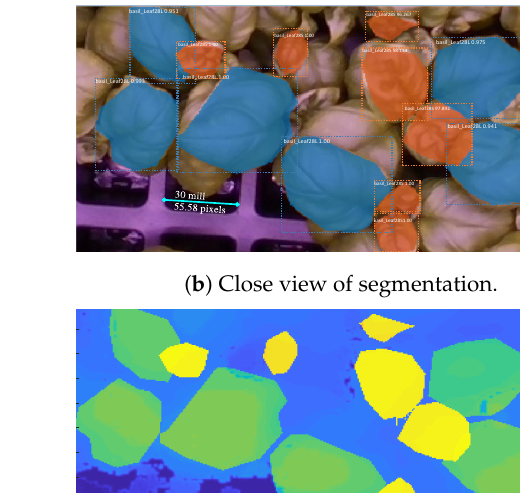
( b ) Close view of segmentation.